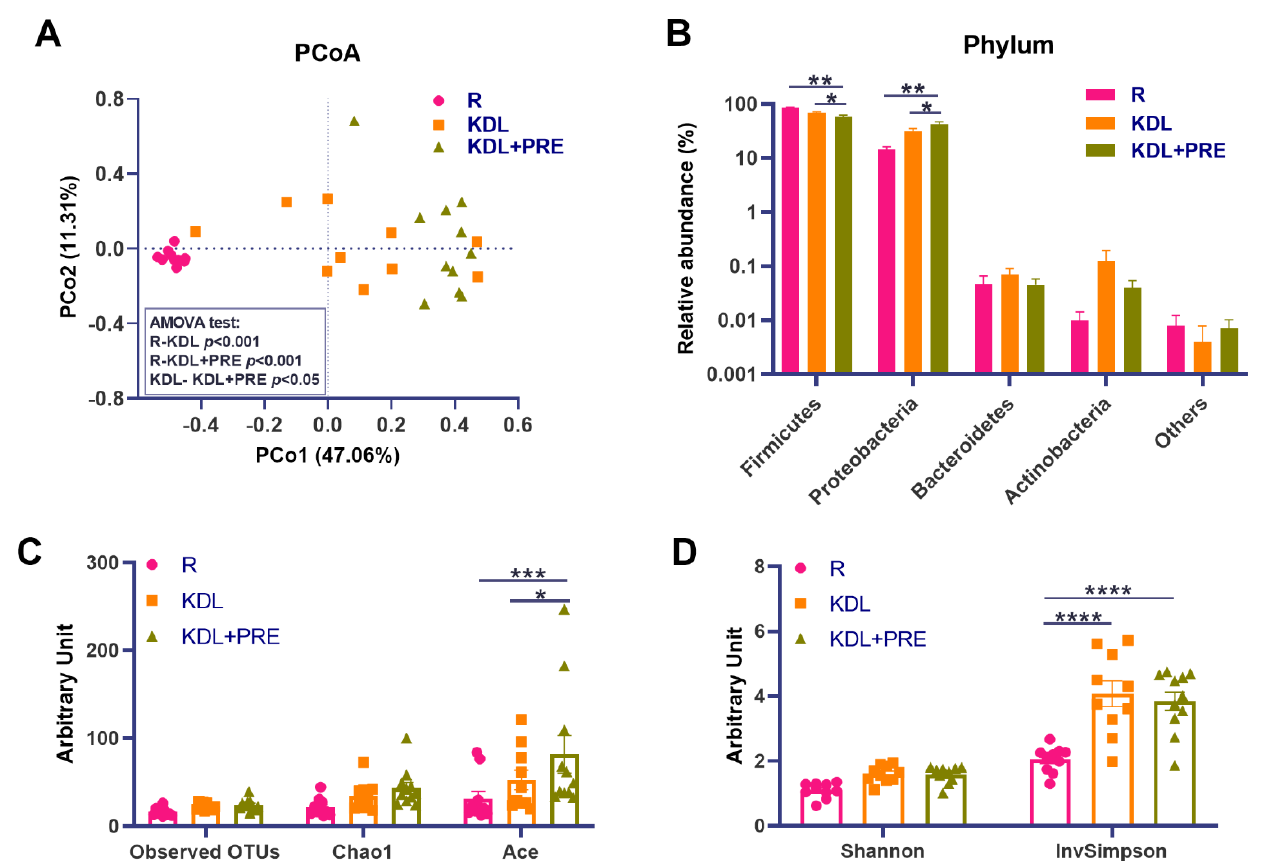
Figure 5. Effects of prebiotic inclusion on the microbiota community structure. ( A ) Principal co- ordinates analysis of microbial structures. ( B ) Phylum-level composition. α -diversity parameters (Shannon and InvSimpson indices). ( C , D ) α -diversity parameters (observed OTUs, Chao1, and Ace indices). R-normally developing reference group; KDL-ketogenic diet formula; KDL+PRE-ketogenic diet formula plus prebiotic fiber; OTU-operational taxonomic unit; PCoA-principal co-ordinates analysis. Data are presented as mean ± SEM. n = 10–11 rats/group. * p < 0.05, ** p < 0.01, *** p < 0.001, **** p < 0.0001.